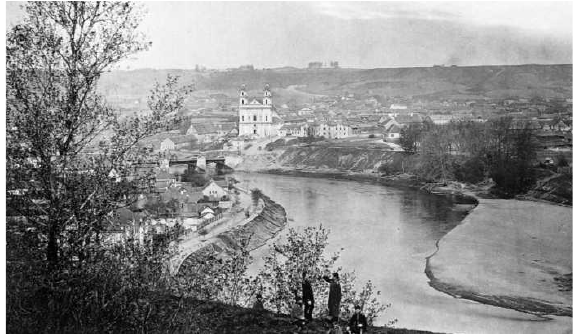
Fig 1. View of Šnipiškės from Pilies Hill. Juozapas Čechavičius’ photo (1819–1888). Lithuanian National Museum, Vilnius, 1995